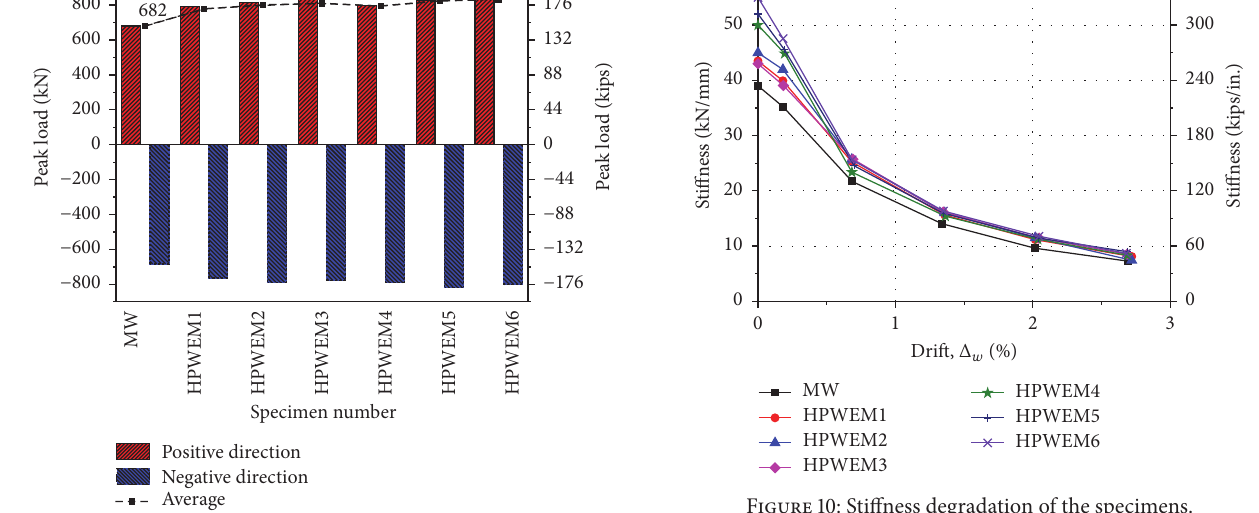
Figure 10: Stiffness degradation of the